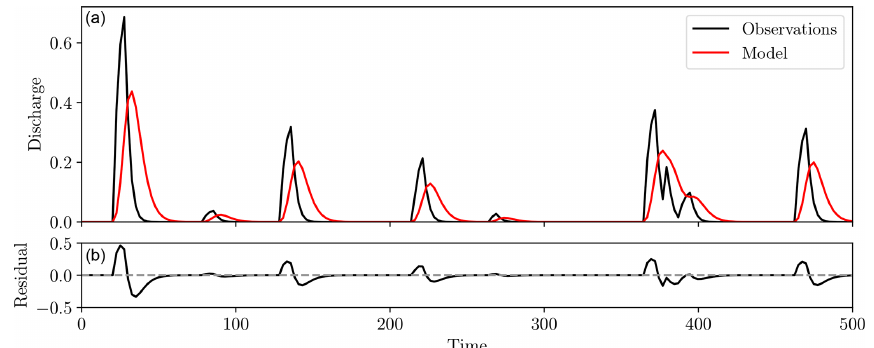
Figure 1. Two hydrographs ( a , red and black) and the point-wise residuals between them (b) . Both timing and amplitude differences are observed, but these are combined into a single amplitude error to give large residuals, even though the human eye might perceive these two distributions as being quite close.